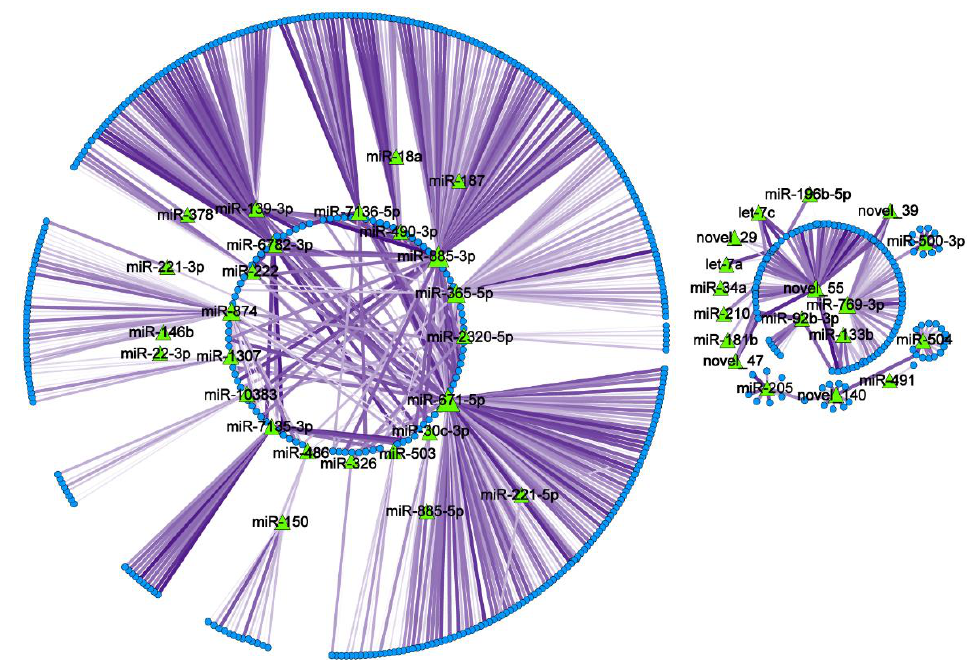
Figure 5. miRNA-mRNA interaction network diagram. Green triangles represent miRNAs, blue dots represent mRNAs, lines between miRNA–mRNA indicate interaction and the purple gradient of the line represents the absolute value of the correlation coefficient (dark color—large correlation coefficient, strong correlation. light color—small correlation coefficient, weak correlation), and the thickness of the line represents the p -value for predicting the significance of the miRNA–mRNA negative correlation (thick, the difference is extremely significant, thin, significant difference).